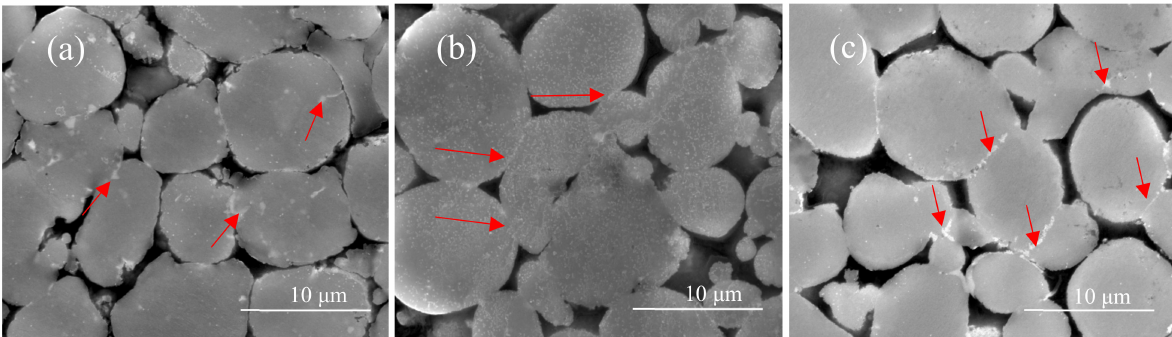
Figure 9. Microstructures of the specimens sintered at different temperatures and times in the vacuum. ( a ) 580 ◦ C, 100 min. ( b ) 600 ◦ C, 100 min. ( c ) 620 ◦ C, 100